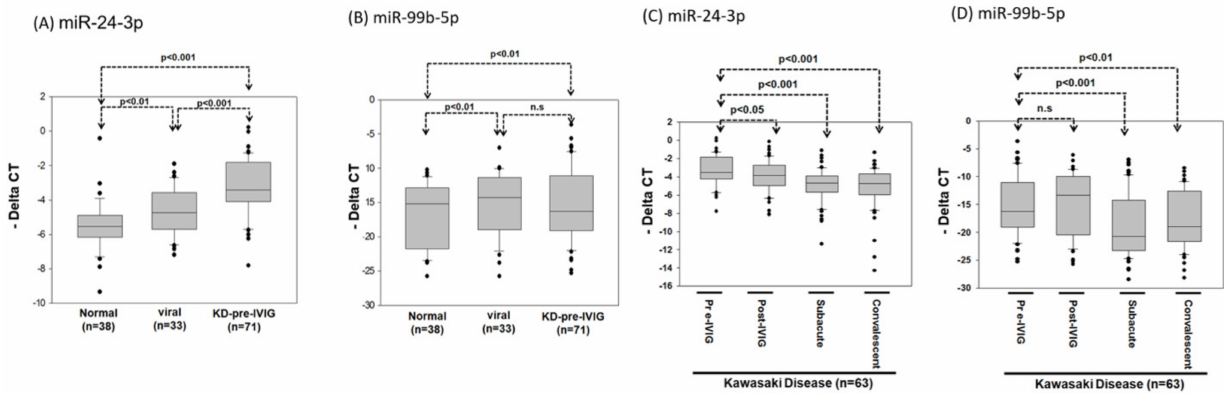
Figure 6. The expression levels of miR-24-3p and miR-99b-5p in the plasma of patients with KD and viral infection or healthy control. The relative expression levels of miR-24-3p ( A ) and miR-99b-5p ( B ) were examined in plasma from 38 healthy controls, 33 participants with viral infection, and 71 patients with KD using the TaqMan real-time PCR. ( C , D ) The relative expression levels of miR-24-3p and miR-99b-5p were examined in plasma from 63 patients with KD at four stages: pre-IVIG treatment, post-IVIG treatment, subacute, and convalescent using the TaqMan real-time PCR. The miR-16 was used as an internal control to normalize the expression levels of miRNA candidates (deltaCt miRNA candidates = Ct miRNA candidates − Ct miR-16